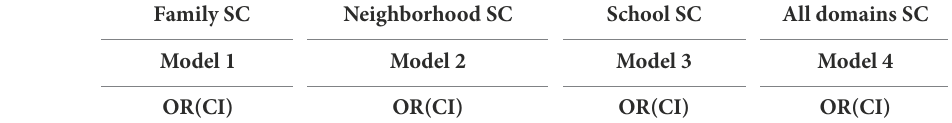
TABLE 4 Odds ratios for high psychological distress in the